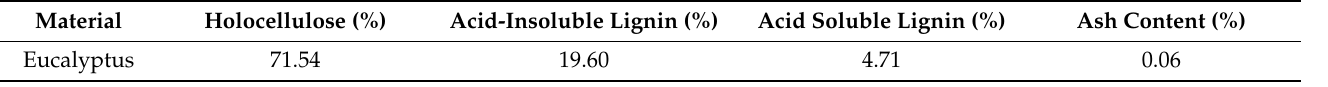
Table 1. Contents of cellulose, lignin and hemicellulose in eucalyptus via NREL protocol. Material Holocellulose (%) Acid-Insoluble Lignin (%) Acid Soluble Lignin (%) Ash Content (%) Eucalyptus 71.54